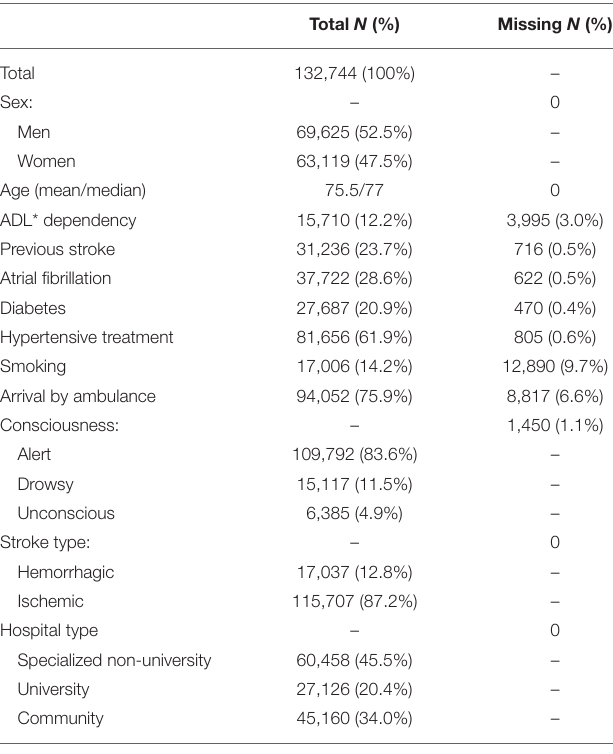
TABLE 1 | Patient